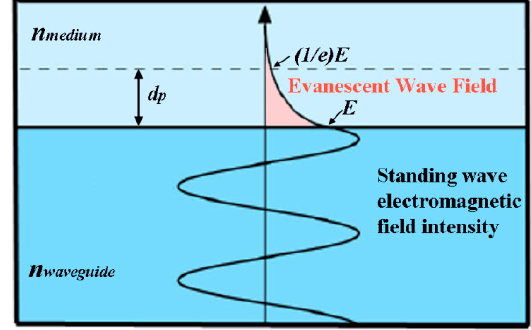
Figure 21. Illustration of a standing wave pattern formed near the interface between a waveguide with a higher refractive index and a medium with a lower refractive index ( n waveguide > n medium ) and the exponentially decaying evanescent wave with the penetration depth of d p .